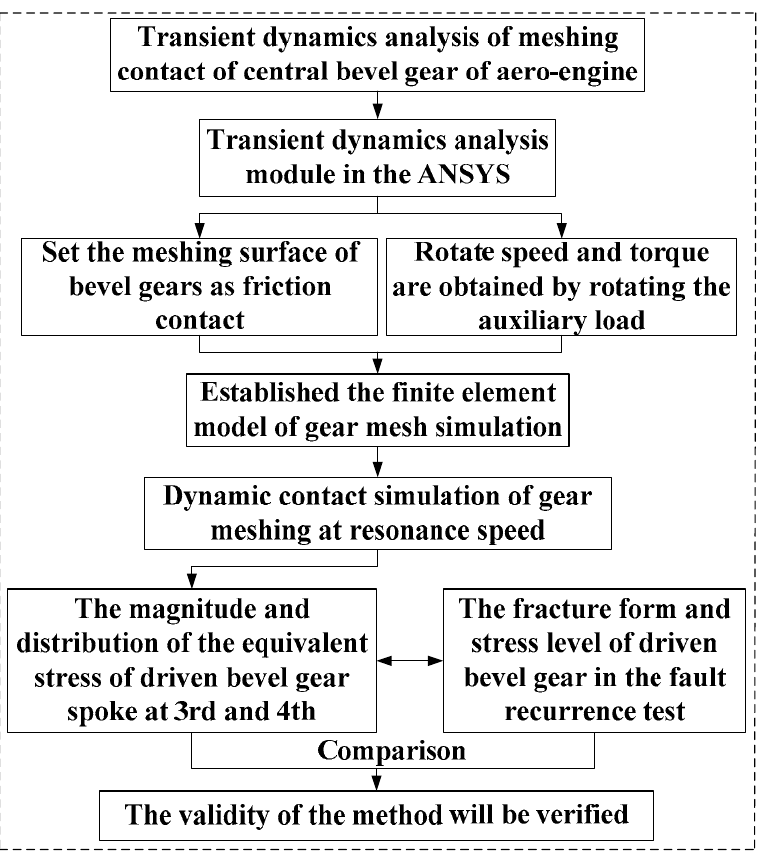
Figure 16. Technical process of gear dynamics simulation. Using FEM to reproduce the working state of the driven bevel gear to verify the reliability of the transient dynamic model. The thickness of the gear speak plate is 10.28 mm, the gear speed at the moment of the driven bevel gear’s 4th ND is calculated by the formula, and the torque of the driving wheel is 101.6 kN · m. When the experimental gear is working, its surface lubricating oil temperature can reach 200 ◦ C. It is assumed that the gear temperature is equal to the oil temperature, so the environmental temperature is set as 200 ◦ C. The model was verified using transient dynamic analysis. The stress at the position monitored in the test was extracted from the calculation results, as shown in Figure 17. The amplitude of the equivalent stress at the position monitored in the test at the resonance rotational speed of the BTW of the 4th ND obtained from the simulations and tests is shown in Table